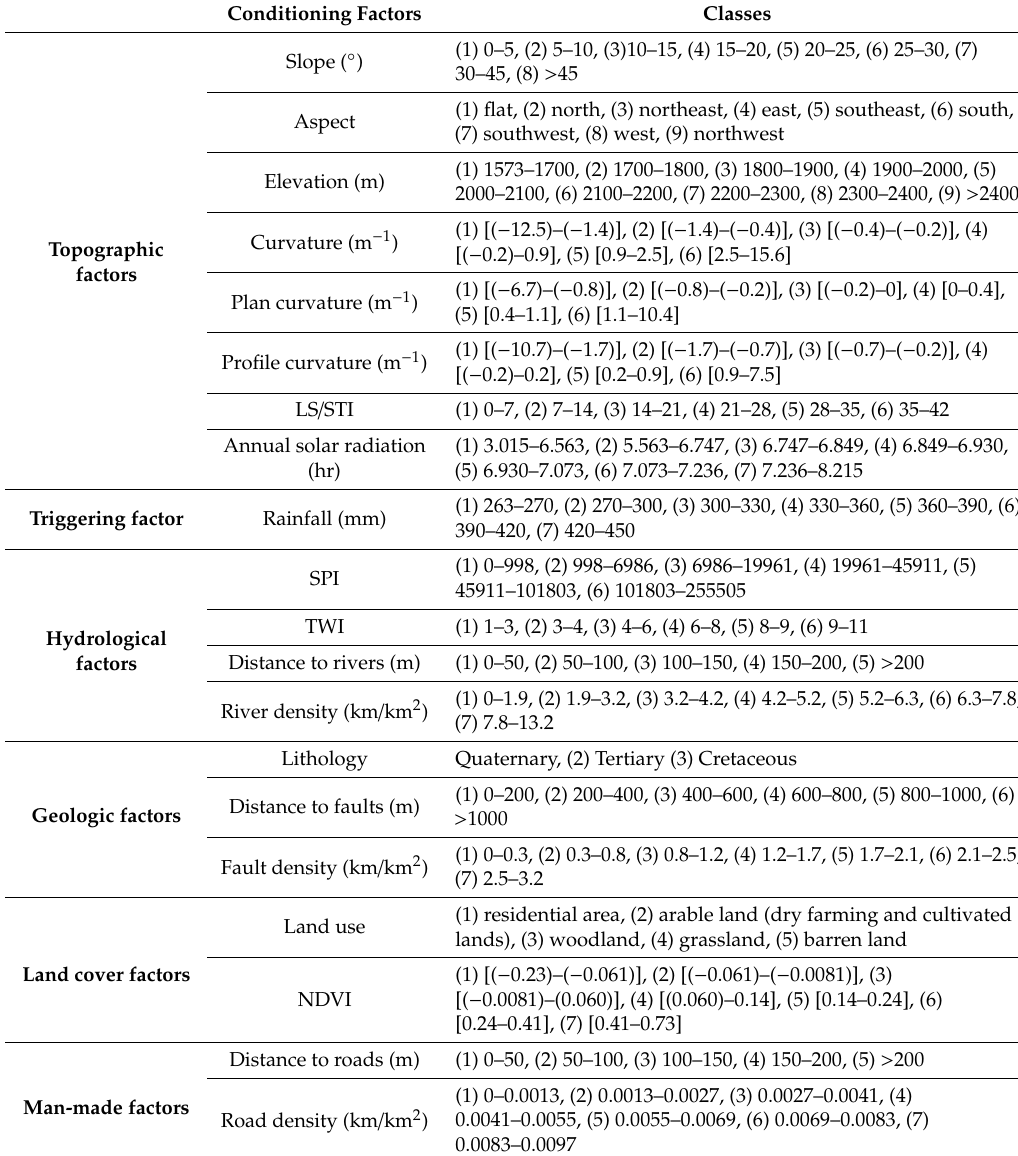
Table 1. Landslide conditioning factors of the study